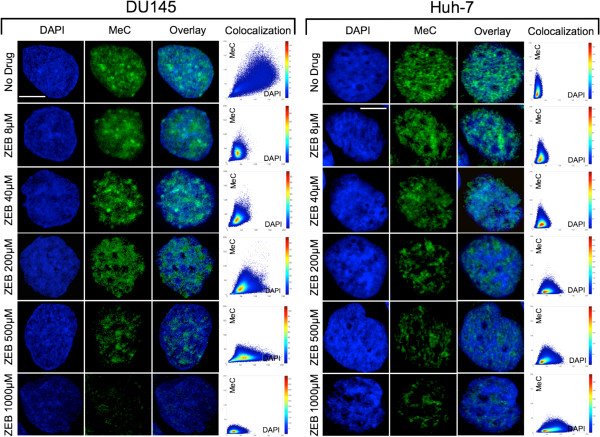
Global differential DNA methylation phenotypes in response to zebularine concentration. Maximum intensity projections (MIP) of 3D-imaged nuclei of DU145 cells with high similarity values within their population category are selected for display (bars are 5 μm). Gradual increase in reduction of MeC sites (false-colored green) was observed in correlation with an increase in zebularine concentration, similarly in both cell types. At lower concentrations (8 and 40 μM) global demethylation seems to be preferentially stronger at the nuclear periphery (delineated by DAPI, false-colored blue) and less DAPI-dense areas (supposedly euchromatin), and gradually affects more interior regions with increased drug concentrations. At higher drug doses (200 μM and especially 500–1000 μM), also more DAPI-dense areas (heterochromatin) have been demethylated. This latter effect is even more pronounced in the AZA-treated cell nuclei (data not shown in here). However, the majority of heterochromatic regions seem to retain their compact conformation. The respective scatter plots of the nuclei provide more quantitative information regarding changes in the MeC/DAPI codistribution as a consequence of drug application, especially for the lower drug doses: a demethylation of non-heterochromatic sites (MeC-positive, low-DAPI signals) is indicated for 40 μM compared to 8 μM, as judged by the decline of the graph slope. This trend correlates with increasing drug concentration. At 200–1000 μM the leveling of the slope towards the x-axis becomes obvious; additionally also strong DAPI-positive sites (heterochromatin) have started to become hypomethylated.